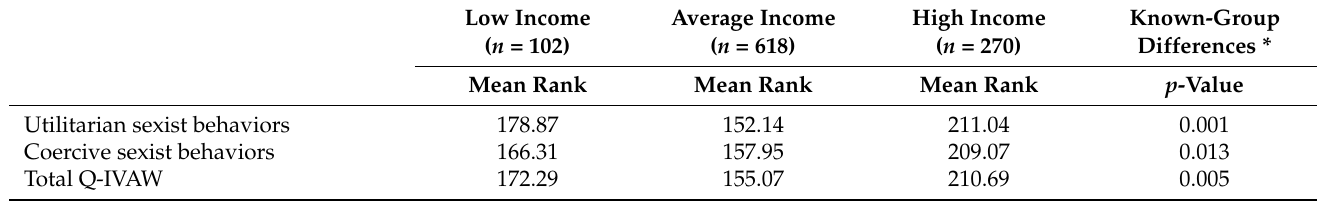
Table 4. Known-group analysis results for the variable “partner’s monthly